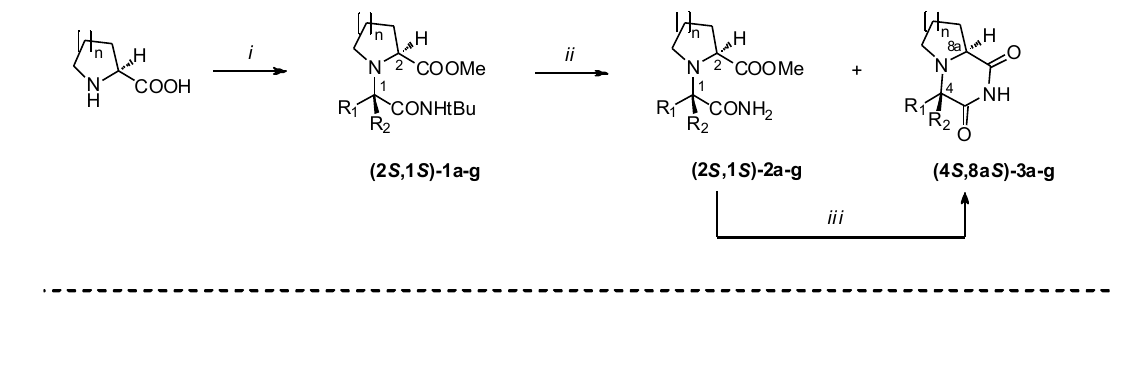
Scheme 1. Synthesis of compounds 1 – 3a – g .